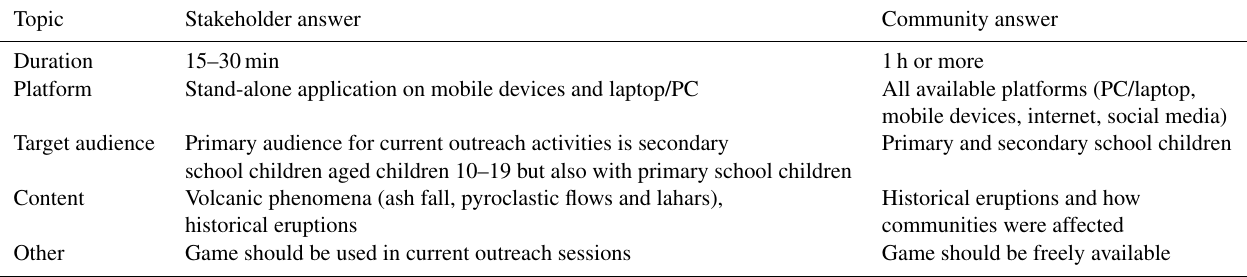
Table 1. Summary of the key ideas and repetitive themes from the user requirements data collection focus groups and online